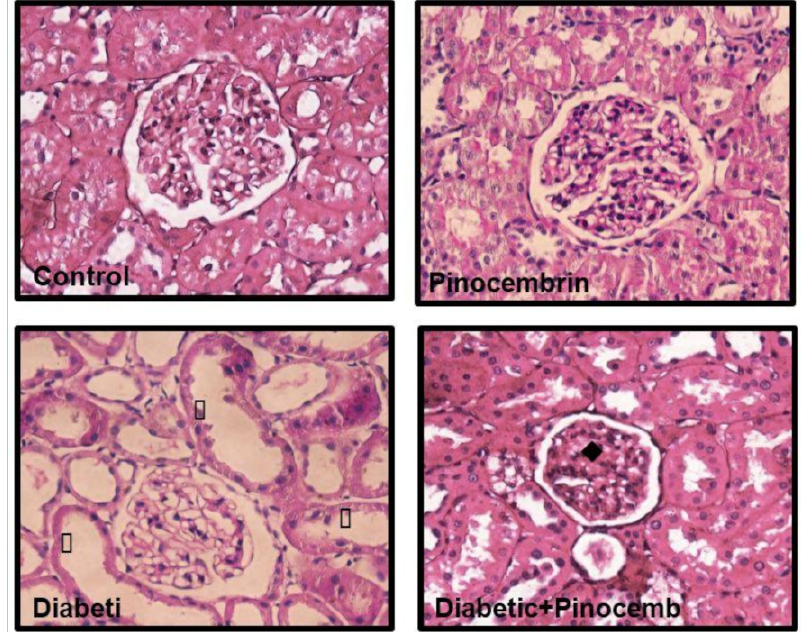
Figure 5. Representative photomicrographs of glomerulus structure in the corrective scheme. Renal structure stained with PAS. Symbols ( (cid:7) ) extracellular matrix accumulation, (